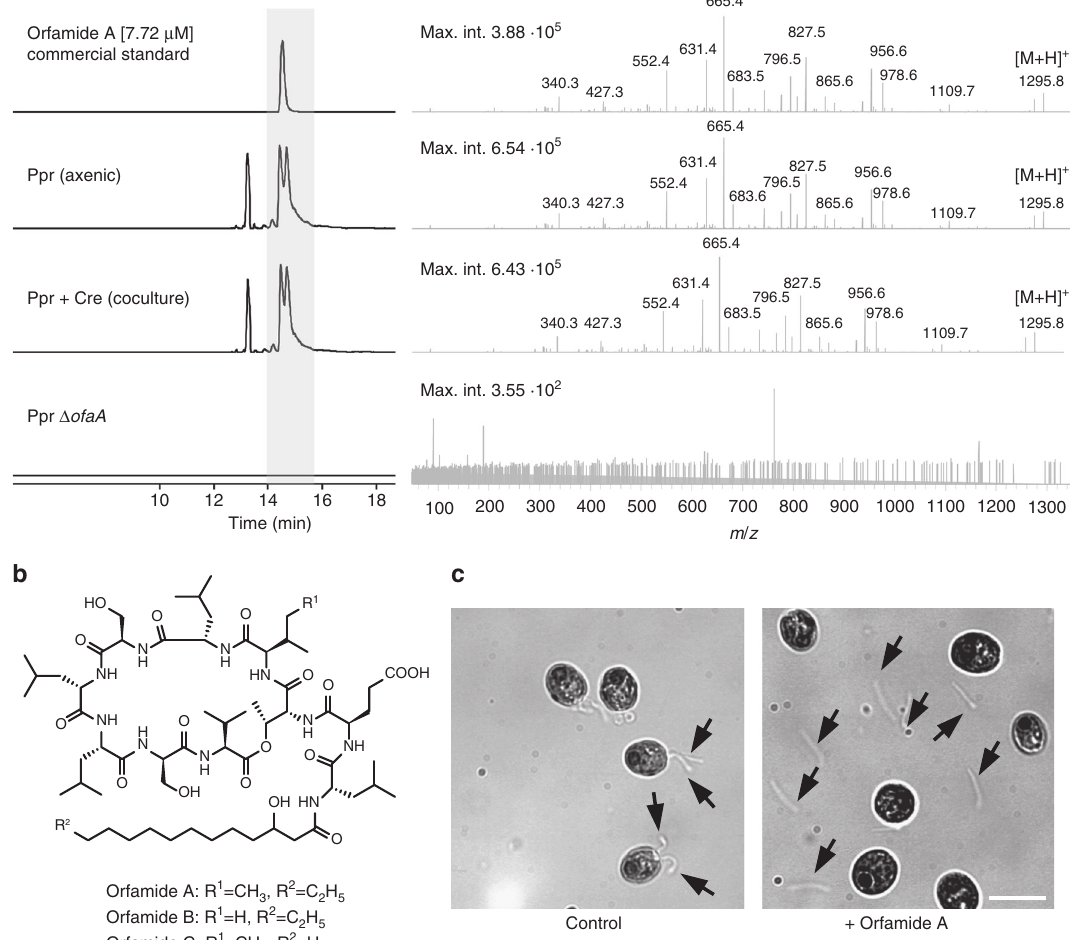
Fig. 2 Orfamide A is released by P . protegens and leads to de fl agellation of the algal cells. a Detection of orfamide A by high-resolution liquid chromatography-tandem mass spectrometry (LC – HRMS/MS). Extracted-ion chromatograms (XIC) of orfamide A (C 64 H 114 N 10 O 17 , accurate